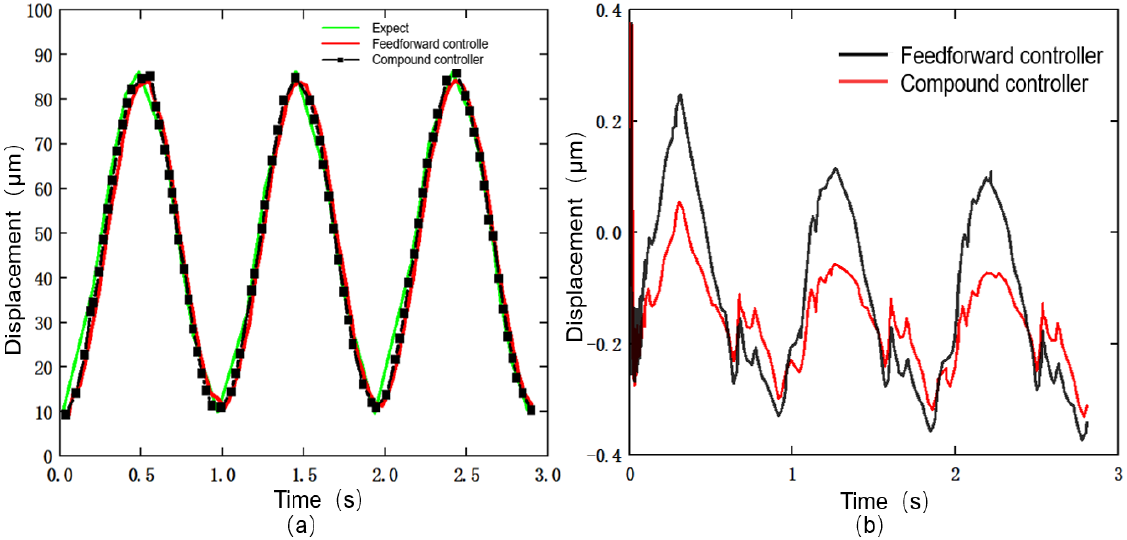
Figure 19. Comparison diagram of feedforward control and composite control effect of 10 Hz signal: ( a ) Comparison of expected displacement and actual displacement. ( b ) Error between expected displacement and actual displacement.